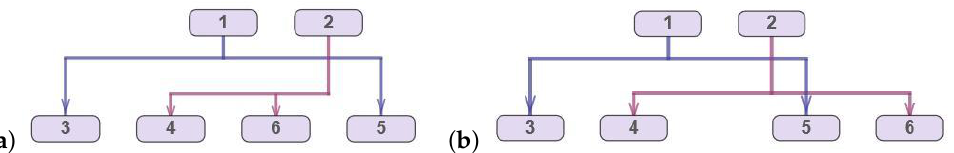
Figure 3. The same reordering nodes on the lower layer of the corresponding hypergraph leads to an increase in the number of hyperedge crossings: one crossing for the layout ( a ) and two crossings for the layout ( b